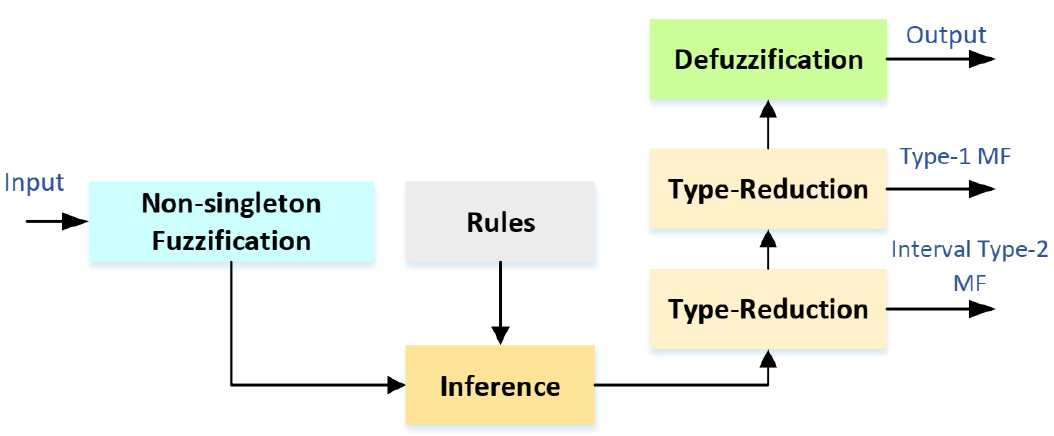
Figure 4. The general structure of NT3FLS.